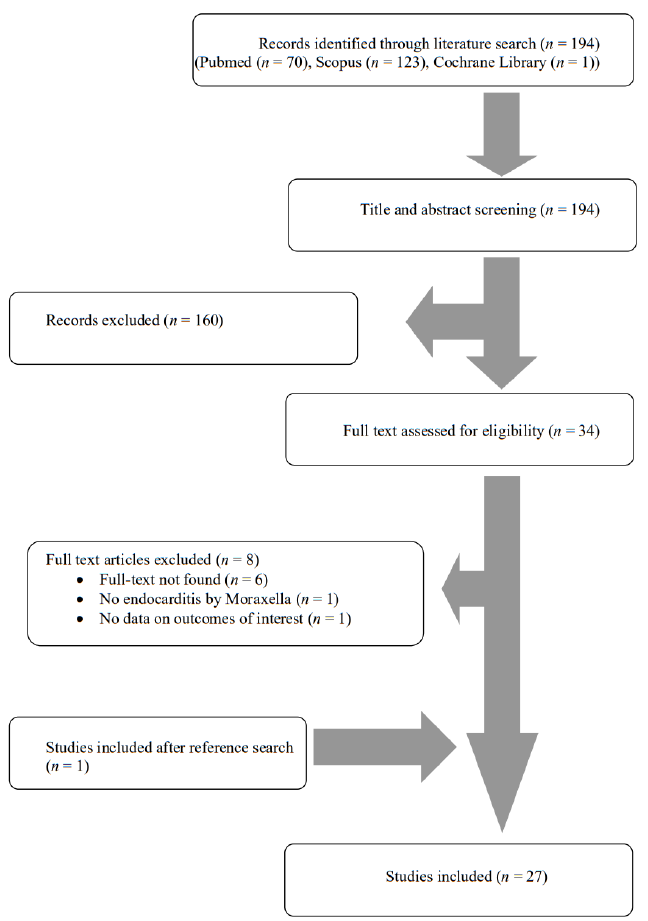
Figure 1. Flow diagram of study inclusion.